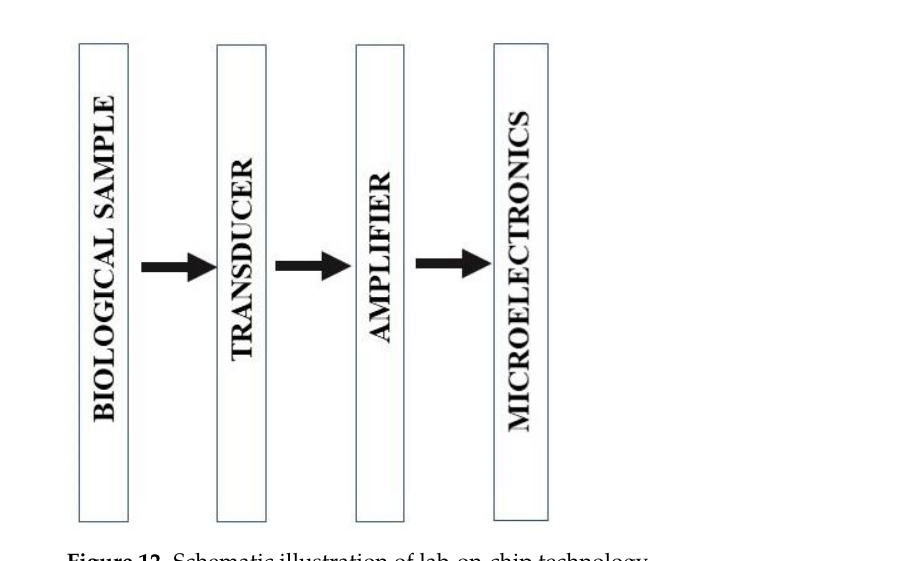
Figure 12. Schematic illustration of lab-on-chip technology.